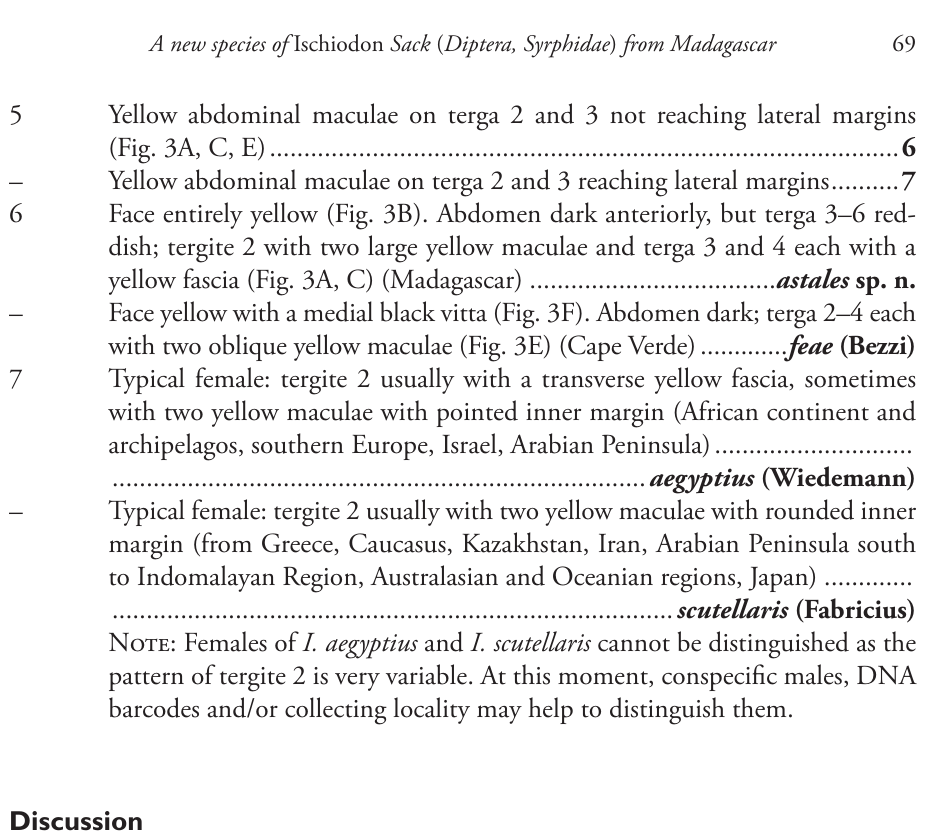
Face yellow with a medial black vitta (Fig. 3F). Abdomen dark; terga 2–4 each with two oblique yellow maculae (Fig. 3E) (Cape Verde) ............. feae (Bezzi) Typical female: tergite 2 usually with a transverse yellow fascia, sometimes with two yellow maculae with pointed inner margin (African continent and